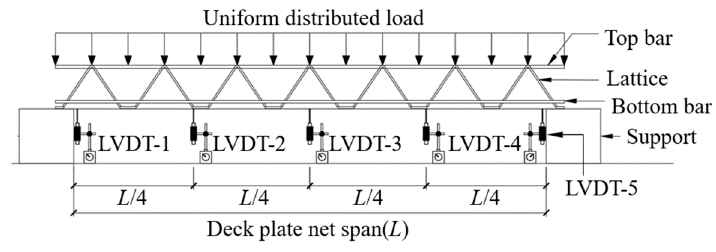
Figure 5. Locations of LVDTs.